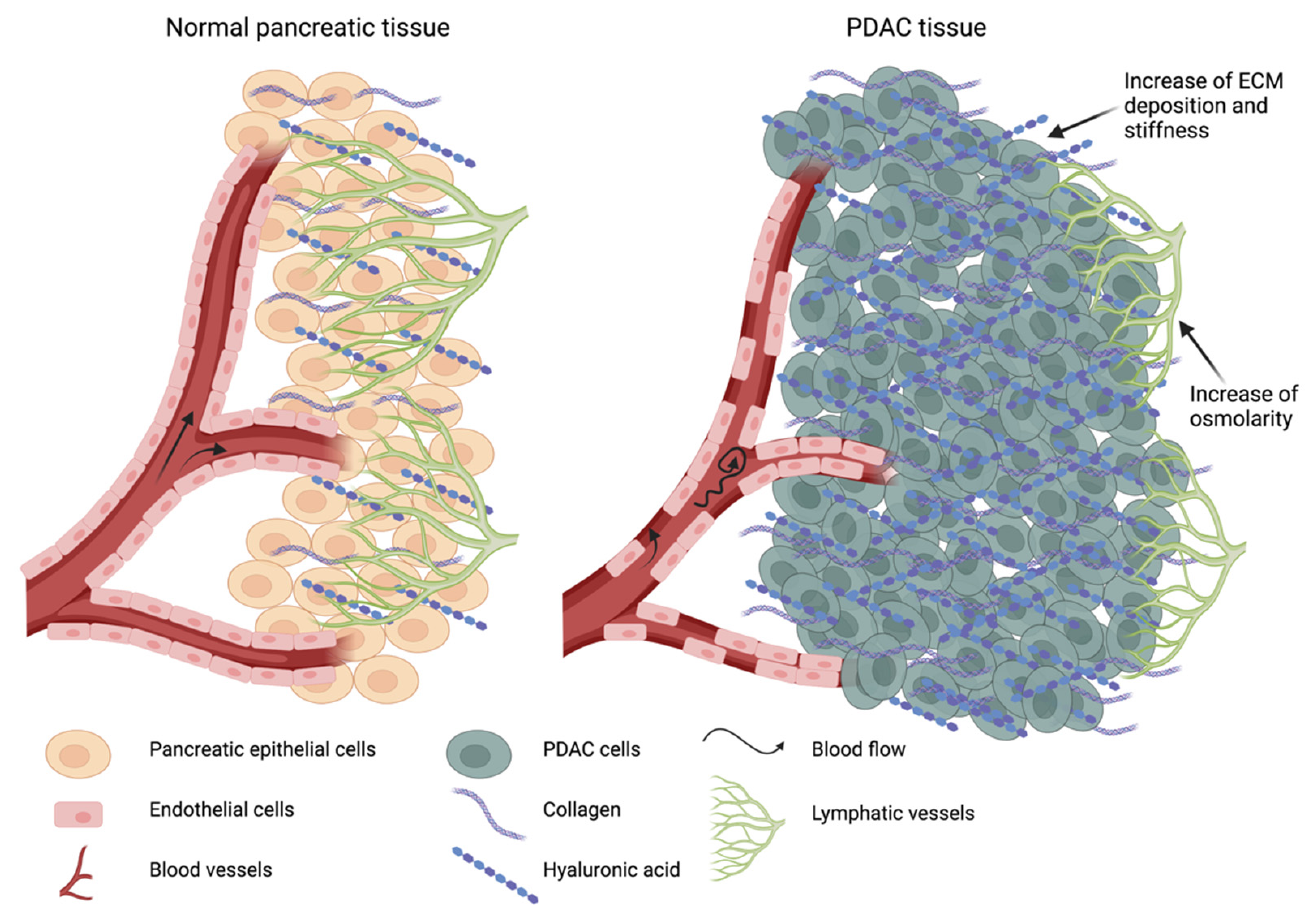
Figure 2. Consequences of ECM stiffness and solid stress. In normal conditions, hyaluronic acid (HA) and collagen fibers are well organized in the pancreatic tissue. There is no stress throughout the tissue and fluids can easily flow from the blood vessels to the interstitium. Functional lymphatic vessels can drain out of the interstitium, keeping its fluid pressure lower than the intravascular pressure. In PDAC, the high deposition of new ECM increases the stiffness, as well as the solid stress within the tumor mass. Meanwhile, HA increases the osmolarity of the interstitial space, inducing an augmented water uptake from the blood vessels. This, along with the fluid leakage and collapse of both blood and lymphatic vessels, increases the IFP, causing an altered fluid